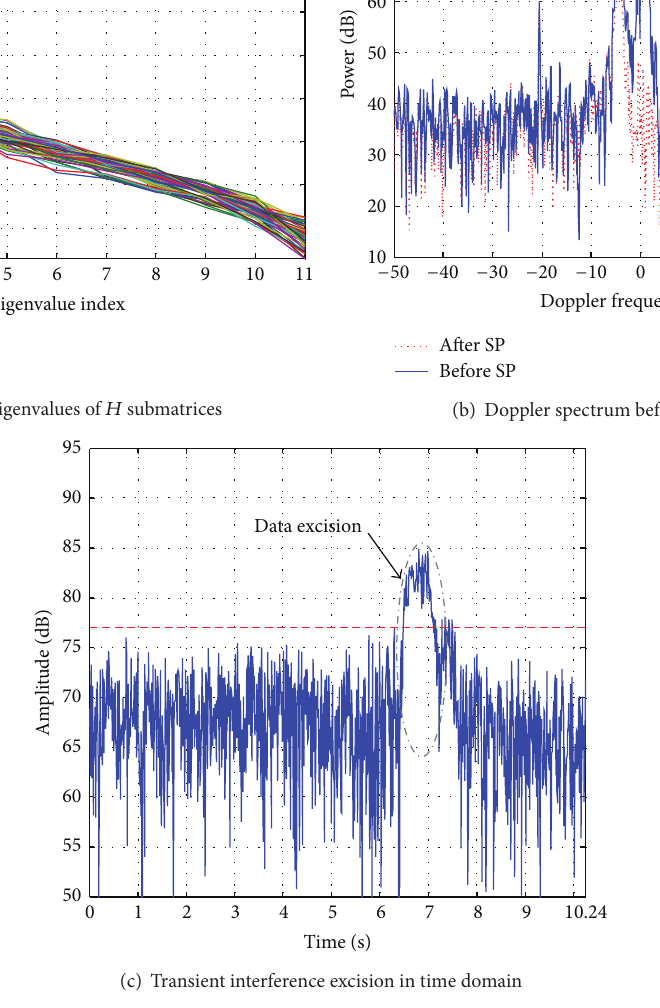
Figure 4: Clutter suppression and transient interference